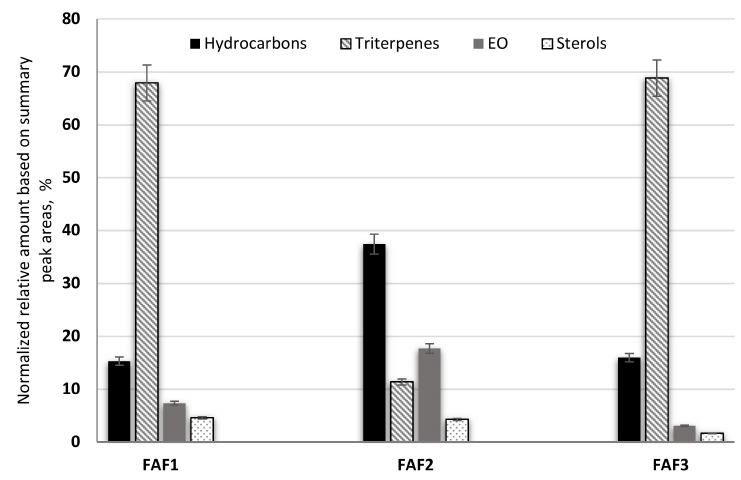
Figure 4. The composition of volatile phytochemical classes in supercritical fluid extracts of Matricaria recutita white ray florets in cyclohexane.